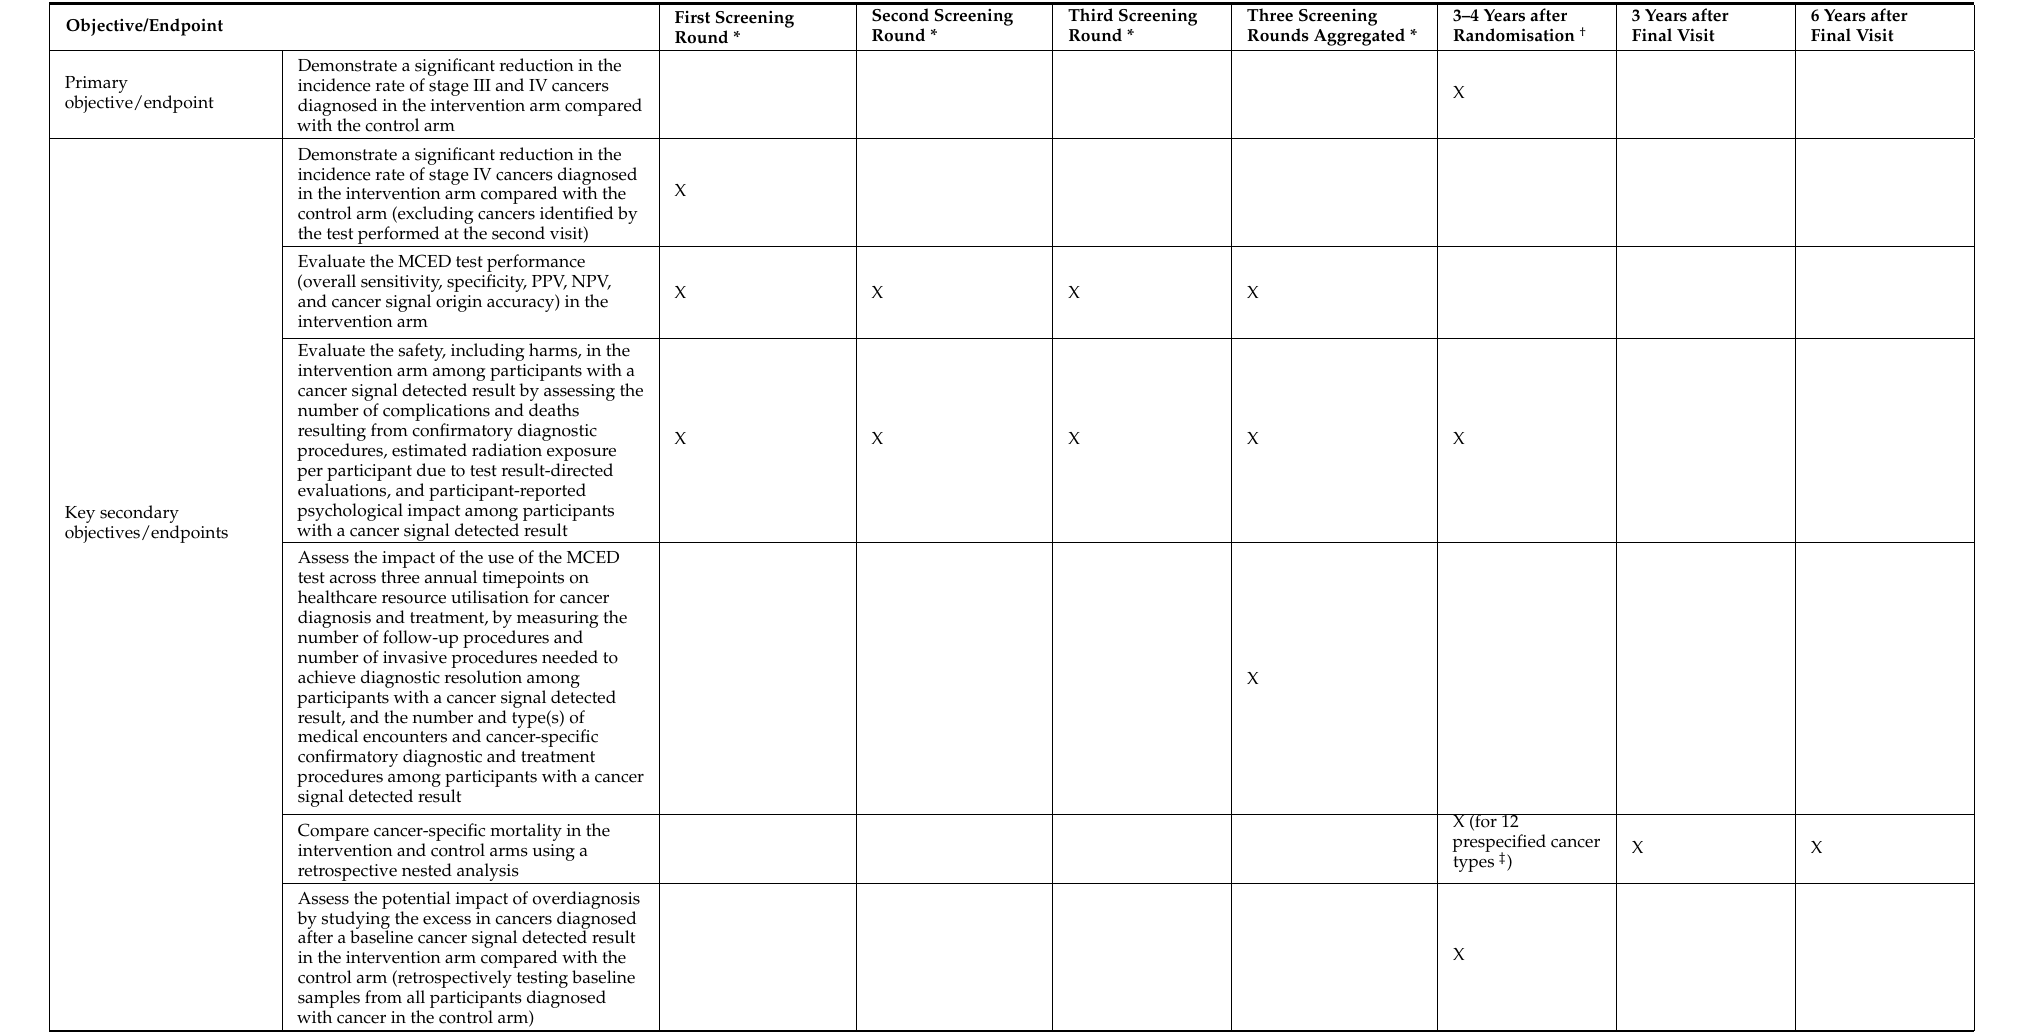
Table 1. Primary, key secondary, and key exploratory objectives and